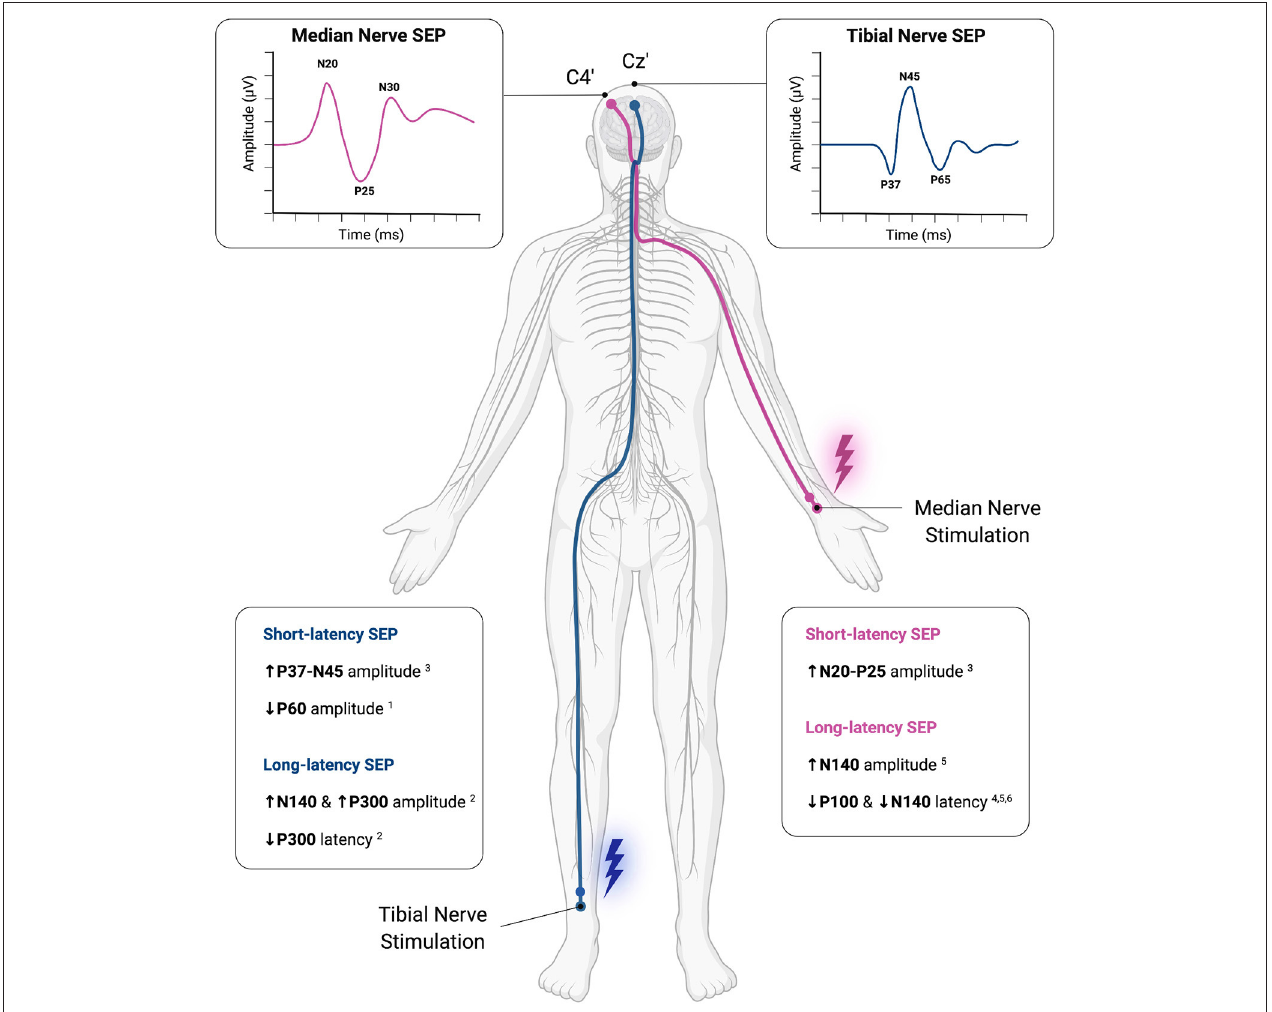
FIGURE 4 | Methodological overview of somatosensory-evoked potential (SEP) application and summarized results of SEP modulations observed in athletes. Commonly, electrical stimulation of a peripheral nerve, i.e., median nerve (Violet) and tibial nerve (dark blue) is applied to examine upper and lower limb evoked responses, respectively. Evoked responses are recorded time-locked and averaged using EEG with different latencies from the onset of peripheral stimulation (e.g., N20, P37). Differences between athletes and healthy controls or between cohorts of athletes from different sports have been found for both short- and long-latency SEPs. These results suggest, that functional neuroplasticity within the somatosensory system in athletes may be identified via SEP recordings. This figure was created with Biorender.com. 1 Bulut et al. (2003); 2 Iwadate et al. (2005); 3 Murakami et al. (2008); 4 Yamashiro et al. (2013); 5 Yamashiro et al. (2015); 6 Yamashiro et al.